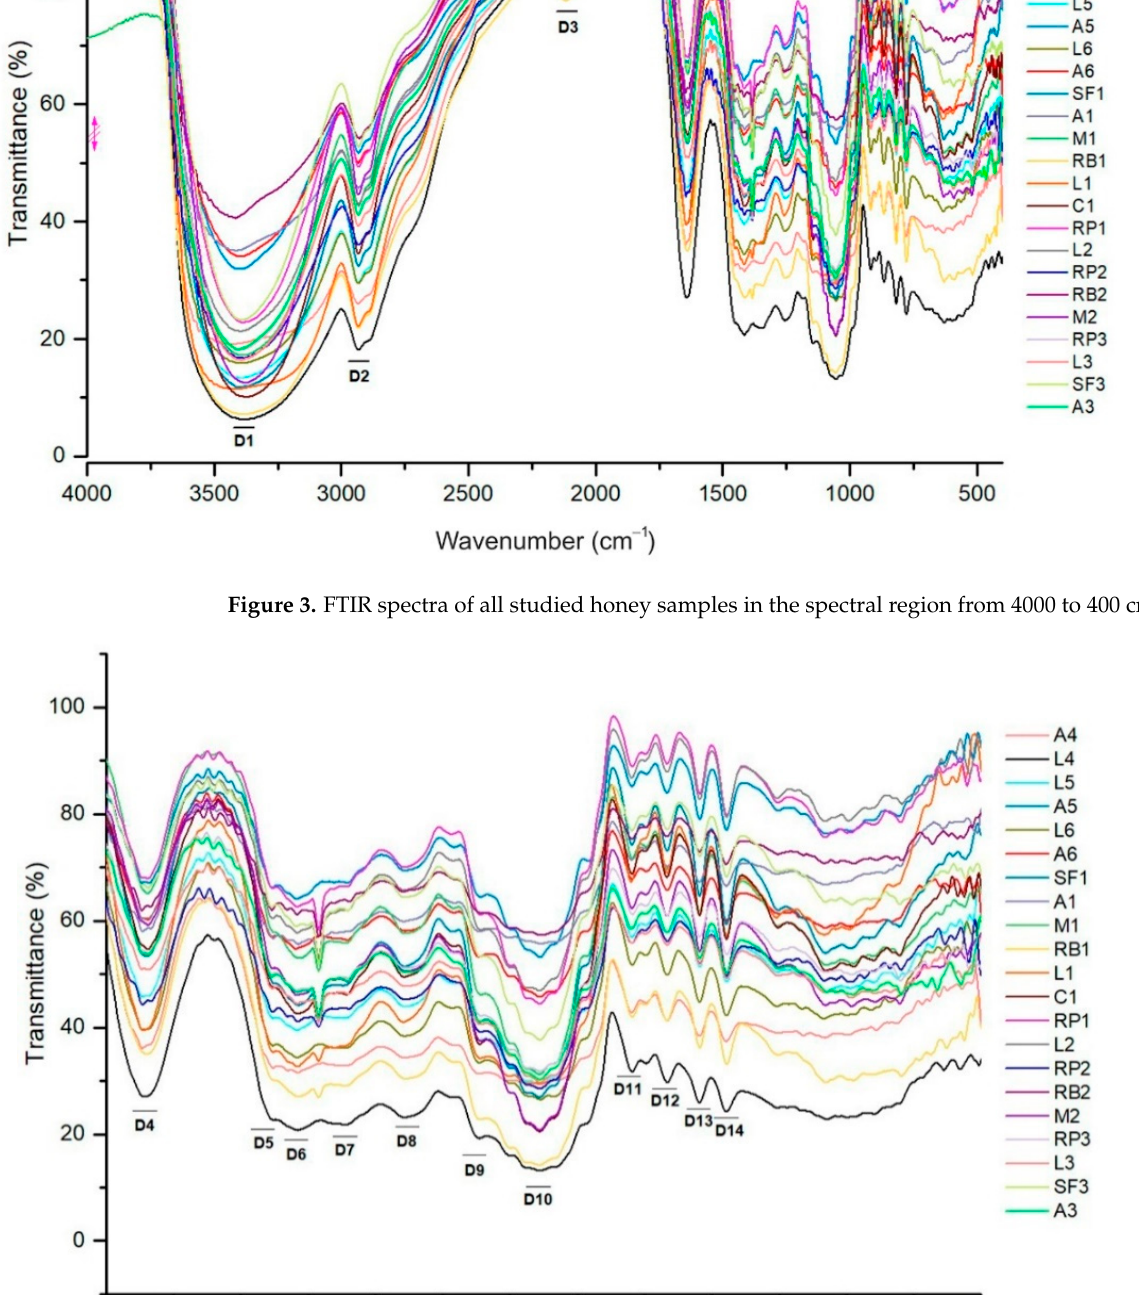
Figure 4. FTIR spectra of all studied honey samples in the spectral region from 1700 to 400 cm − 1